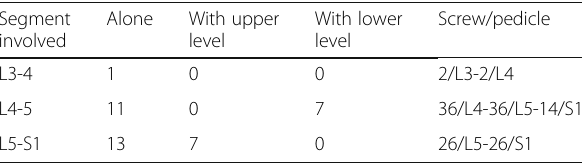
Table 1 Distribution of segments involved and pedicles used for fixation Segment involved